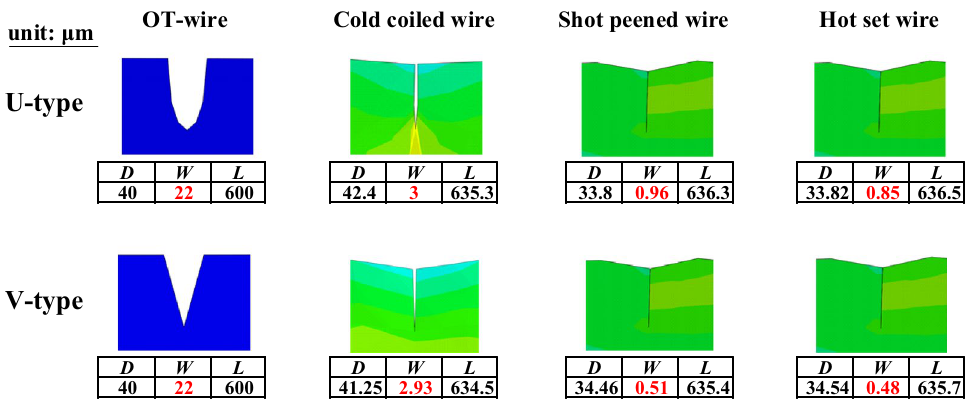
Figure 16. Deformation of U- and V-type surface flaws during the manufacturing